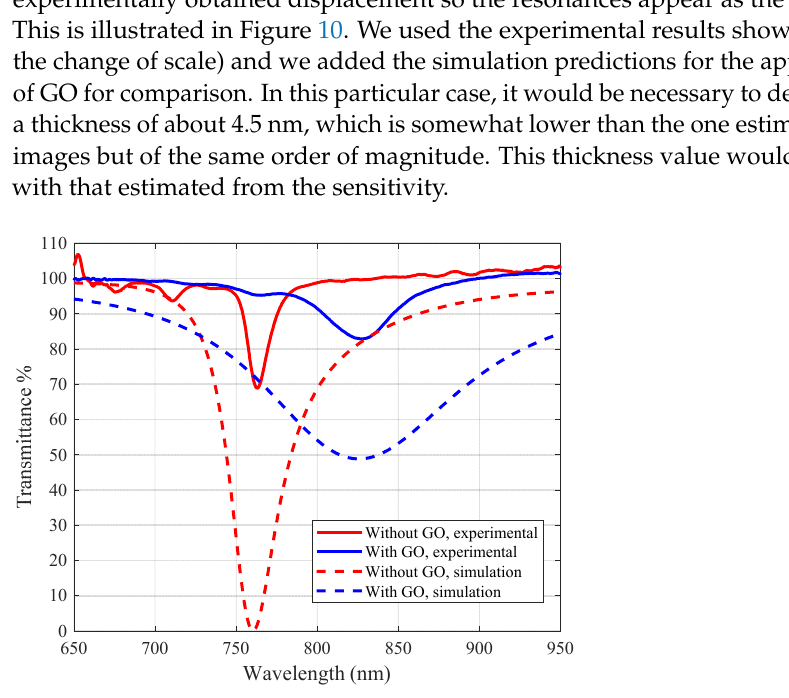
Figure 10. Experimental spectral transmittance in water as an external medium of a DL-UWT with (blue lines) and without (red lines) a GO deposit (solid lines) and the corresponding simulations (dashed lines) to estimate the equivalent layer thickness.